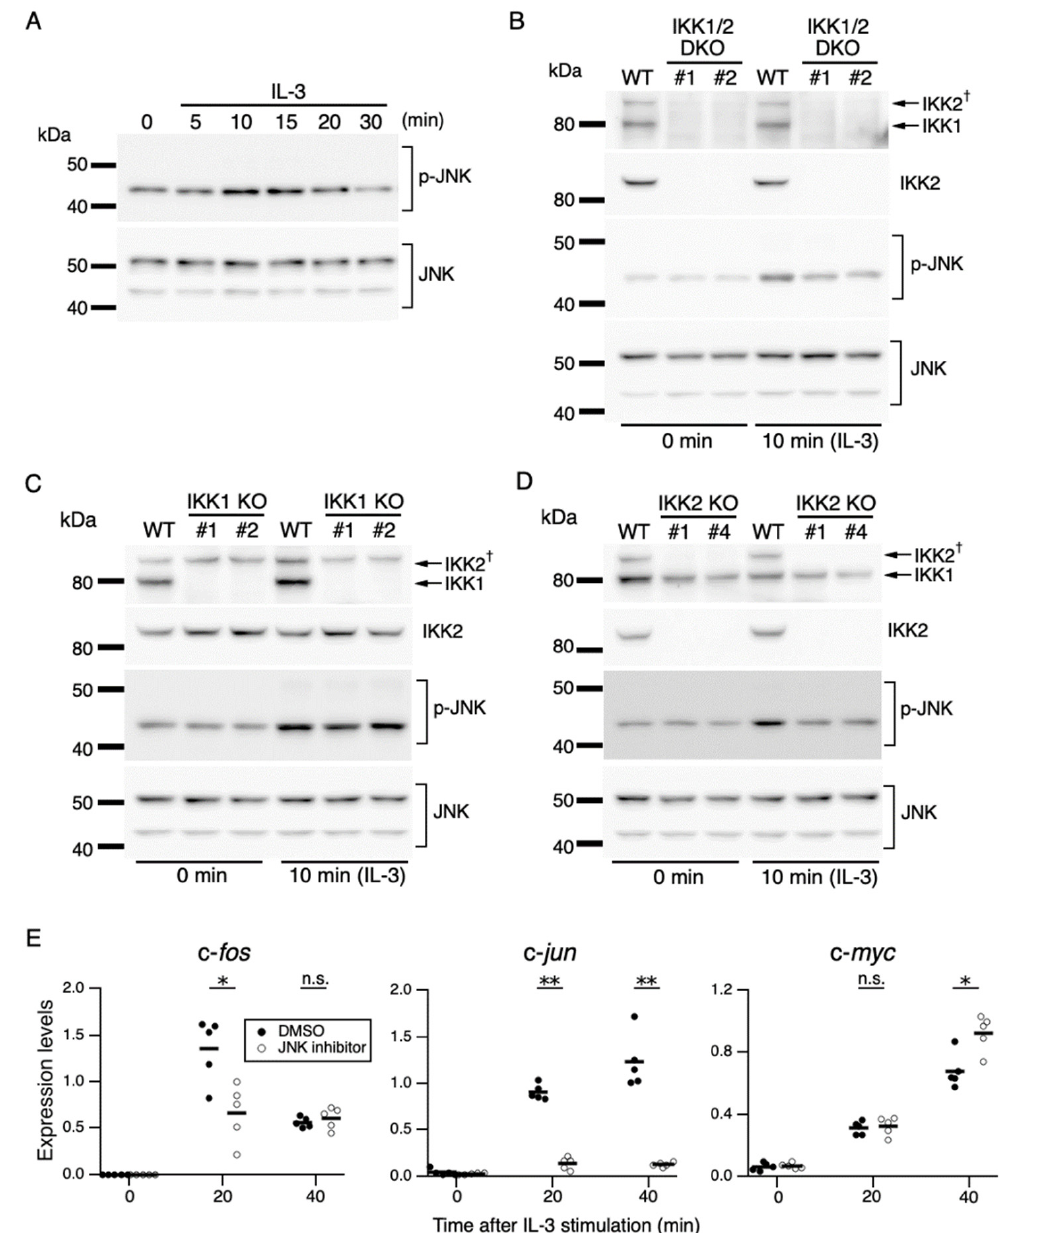
Figure 4. IKK2-mediated activation of JNK regulates c- fos and c- jun expression. ( A ) Phosphorylation of JNK after IL-3 stimulation. Following IL-3 deprivation for 6 h, Ba/F3 cells were stimulated with IL-3 for the indicated durations, and whole-cell lysates were subjected to immunoblot analysis using the indicated Abs. ( B – D ) Phosphorylation of JNK in IKK KO cells after IL-3 stimulation. Ba/F3 parental (WT), IKK1 KO, IKK2 KO, and IKK1/2 DKO cells were stimulated with IL-3 after IL-3 deprivation for 6 h. Immunoblot analysis was performed with whole-cell lysates using the indicated Abs. ( E ) Expression levels of c- fos , c- jun , and c- myc mRNAs 20 and 40 min after IL-3 stimulation in the presence of JNK-IN-8 or DMSO. Ba/F3 cells were pre-incubated with 0.5 µ M JNK-IN-8 or DMSO for 6 h and then stimulated with IL-3. * p < 0.05; ** p < 0.01; n.s., not significant, as assessed by Mann-Whitney U -tests, for differences between JNK-IN-8-treated and control cells at each time point. Each dot represents the result from independent experiments ( n = 5). Means are indicated by